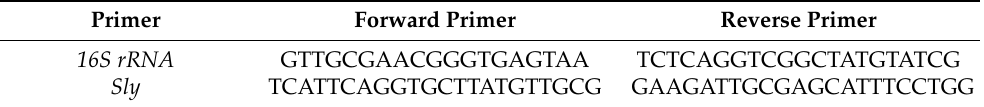
Table 2. The primers used for RT-qPCR in this